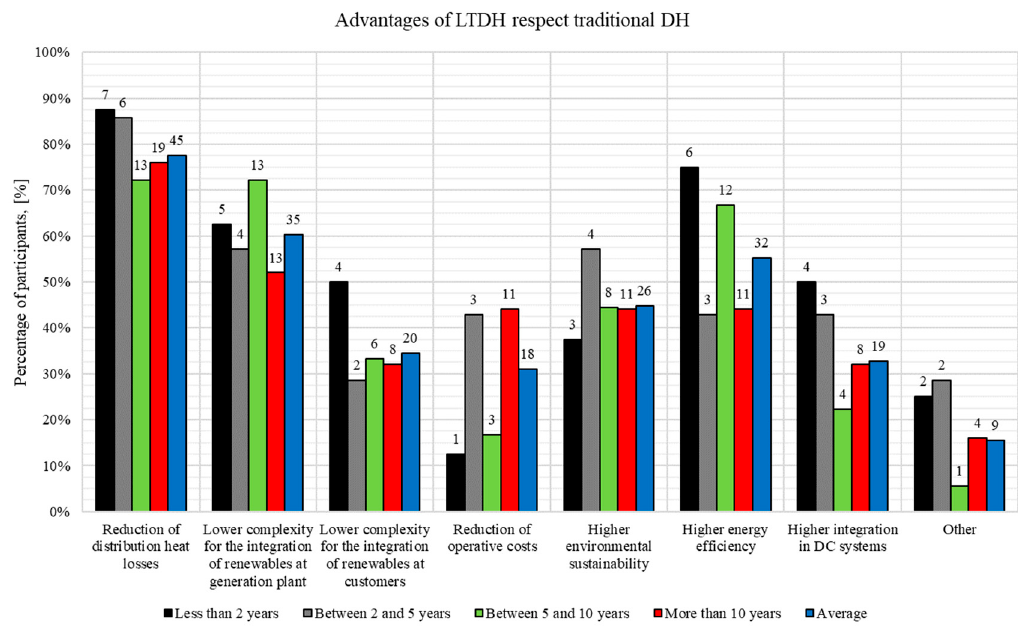
Figure 24. Advantages of LTDH systems with respect to traditional DH as a function of the experience.